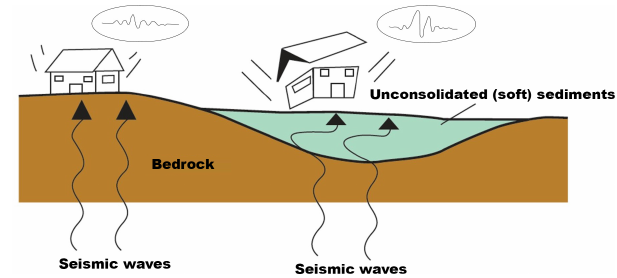
Figure 1. Schematic view of site amplification. Seismogram at the surface shows amplification in comparison to the seismogram lo- cated over the bedrock (modified after Ciaccio and Cultrera,